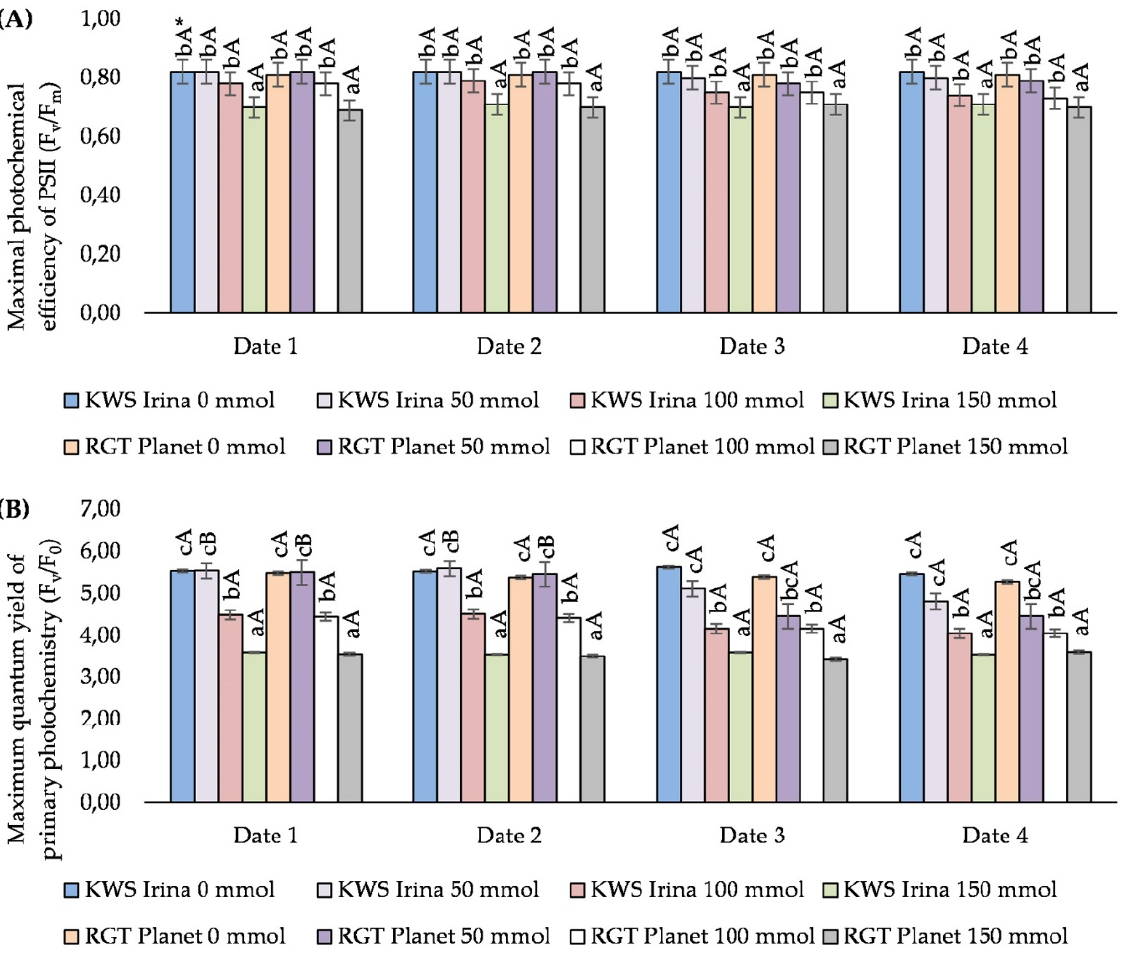
Figure 2. The effect of NaCl (mmol NaCl (dm 3 ) −1 ) concentration and measurement date on chloro- phyll fluorescence parameters: maximal quantum yield of PSII photochemistry (F v /F m ) ( A ), maxi- mum primary photochemistry yield (F v /F 0 ) ( B ), and PS II performance index (PI) ( C ) in the varieties of KWS Irina and RGT Planet (date 1, 7 days after NaCl application; date 2, 14 days after NaCl application; date 3, 21 days after NaCl application; date 4, 28 days after NaCl application) * Capital letters indicate significant differences between the means in the measurement dates for particular NaCl concentrations, and lower case letters indicate significant differences between the means at subsequent measurement dates ( p = 0.05). 3.3. The Influence of Salt Stress on the Course of Gas Exchange The study showed the significant effect of salinity on the value of the P N . An increase in the NaCl concentration in the soil resulted in a decrease of this parameter in the studied varieties. The greatest differences were noted at concentrations of 100 and 150 mmol (dm 3 ) −1 , and they were on average 25.7% and 59.1% (KWS Irina) and 36.3% and 54.5% (RGT Planet), respectively, in relation to the control. In plants treated with 50 mmol